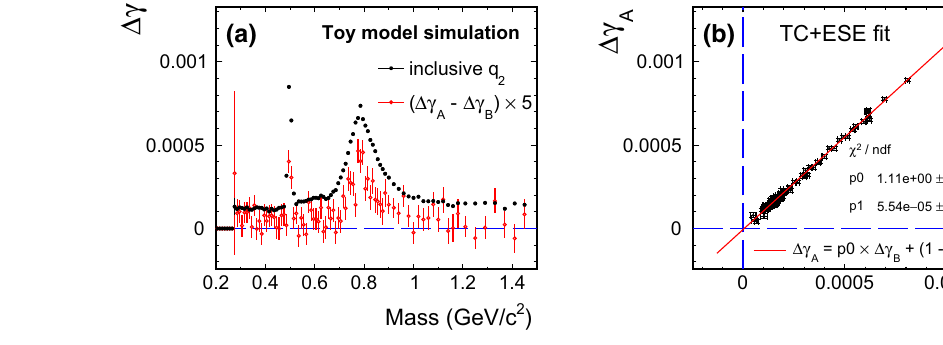
signal is smaller than 10% of the inclusive (cid:2)γ . The fit param- eters are written in Fig. 3(b). The fit parameter for CME is = ( 4 . 2 ± 0 . 2 ) × 10 − 5 , not far away from the input (cid:2)γ CME CME signal of 4 . 6 × 10 − 5 . The fit χ 2 / ndf = 108 / 75 is not ideal because of the approximation for the m inv -dependence of R ( m inv ) , but it presents a potentially viable way to extract CME signals from data even at low m inv